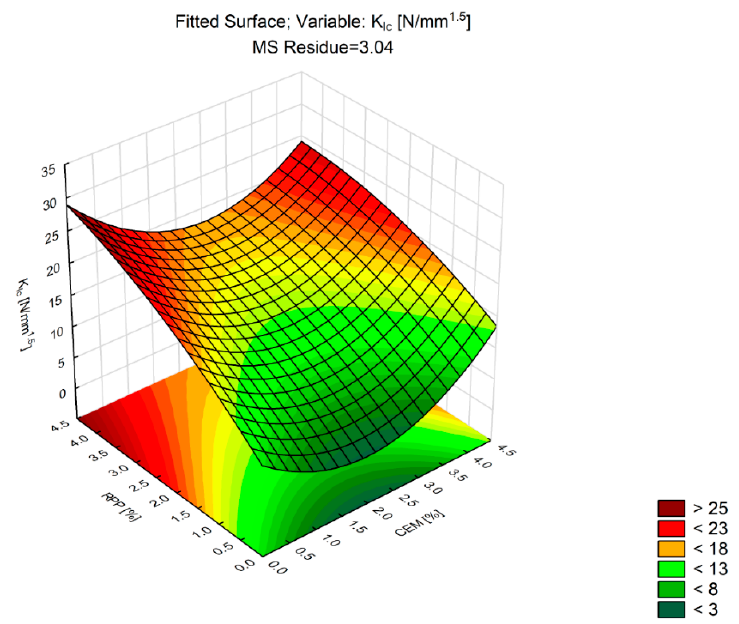
Figure 12. Response surface plot of K IC versus RPP and CEM (CBM).